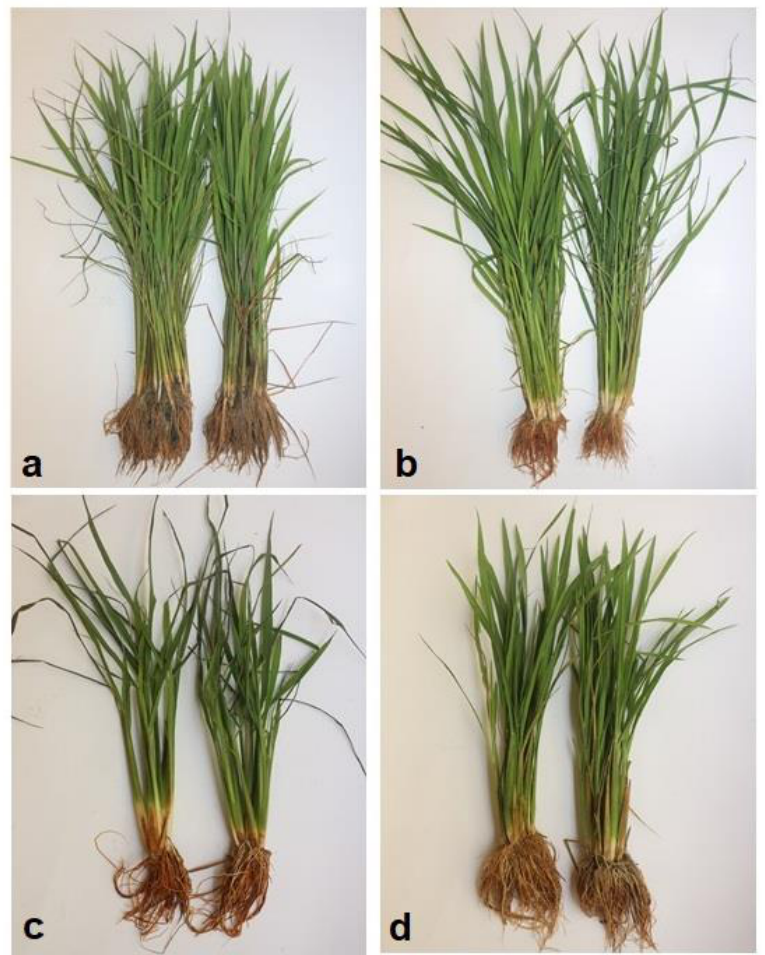
Figure 1. Collected rice plant samples from four different districts of Bangladesh for isolation of salinity tolerant PGPB. Images ( a – d ) of rice plants were collected from the farmers fields in Chattogram, Cox’s Bazar, Lakshmipur, and Noakhali districts of Bangladesh. The age of the collected plants ranged from 35 – 50 days.